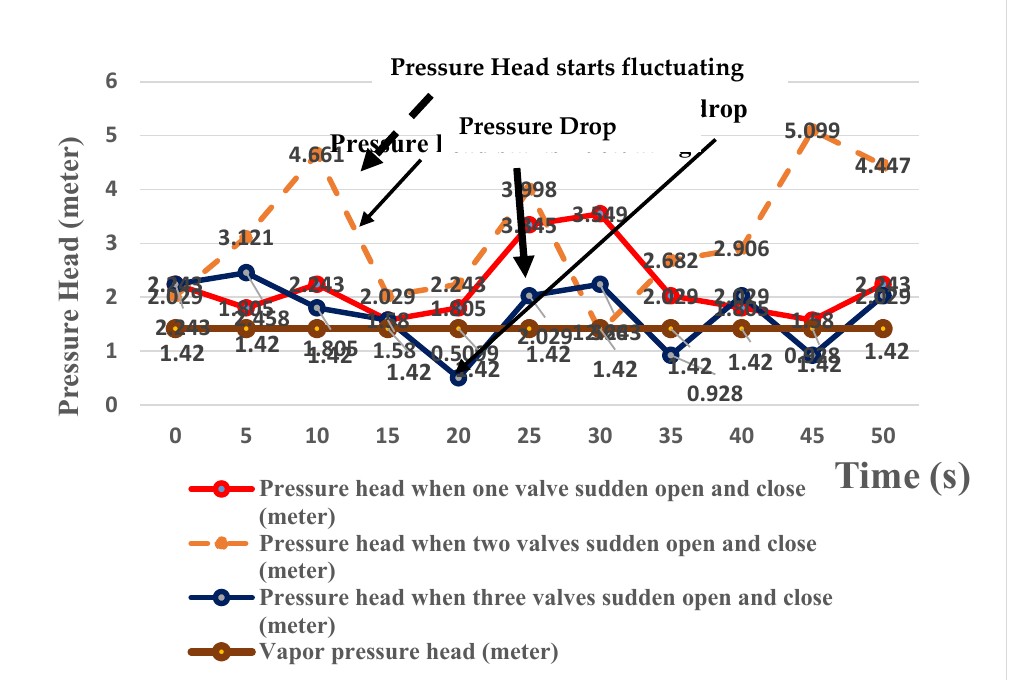
Figure 6. Pressure head processes behind the pump of complete-time series in different positions of the valve.